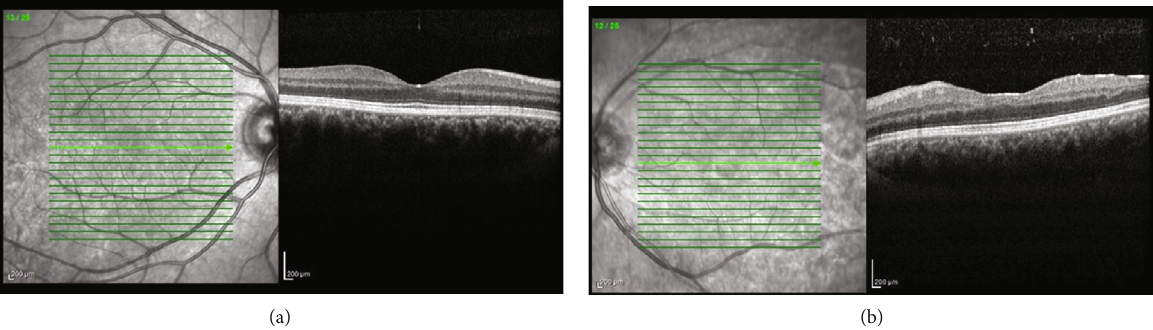
Figure 2: Horizontal macular optical coherence tomography (OCT) of the right eye (a) revealed the normal macular structure and in the left eye (b) revealed inner retinal irregularity and thinning along with foveal splaying (saucerization of the foveal